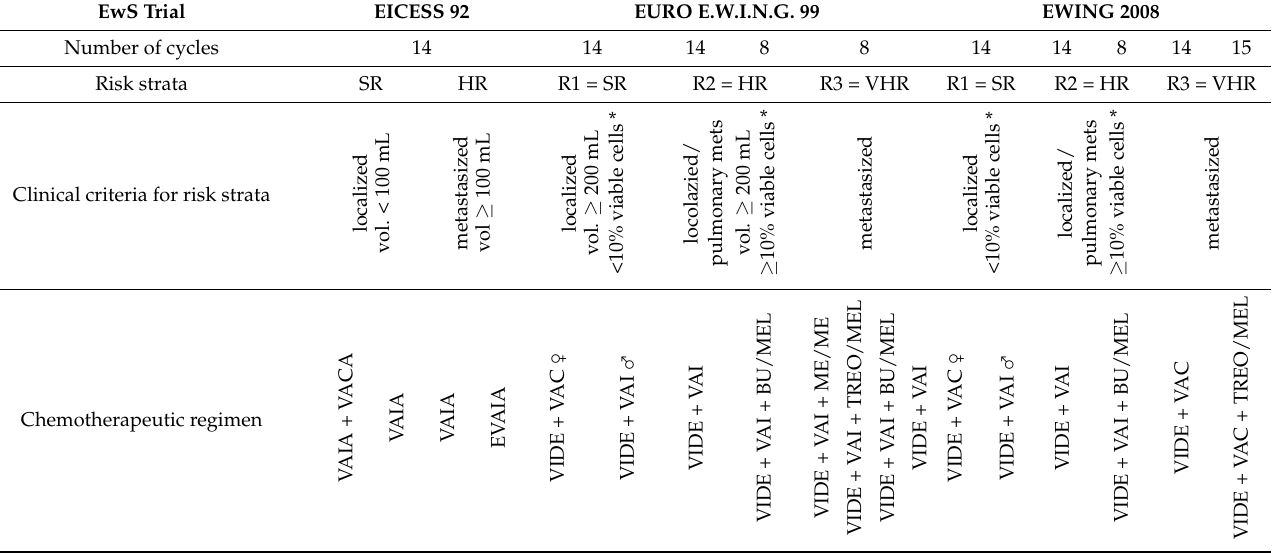
Table 1. Development of risk stratification and chemotherapy for Ewing sarcoma (EwS) in dif- ferent trials from the Cooperative Ewing Sarcoma Study (CESS) group. SR—standard-risk, HR— high-risk, VHR—very high-risk. Please see “Materials and Methods” section for more detailed information on risk strata, including randomization of R1/R2/R3. Vol.—tumor volume at